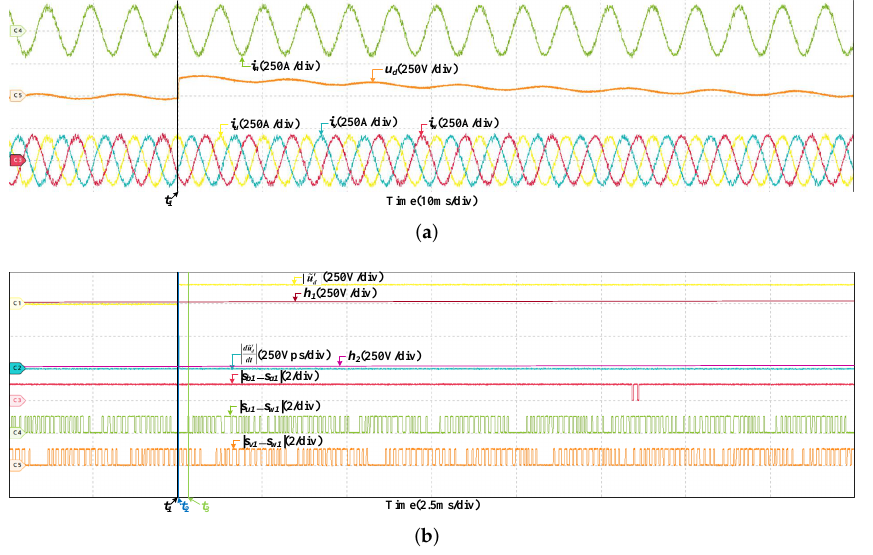
Figure 9. HIL results when the offset fault occurs in S Vd at 300 km/h. ( a ) The results of the grid current, DC-link voltage and stator currents. ( b ) The results of fault